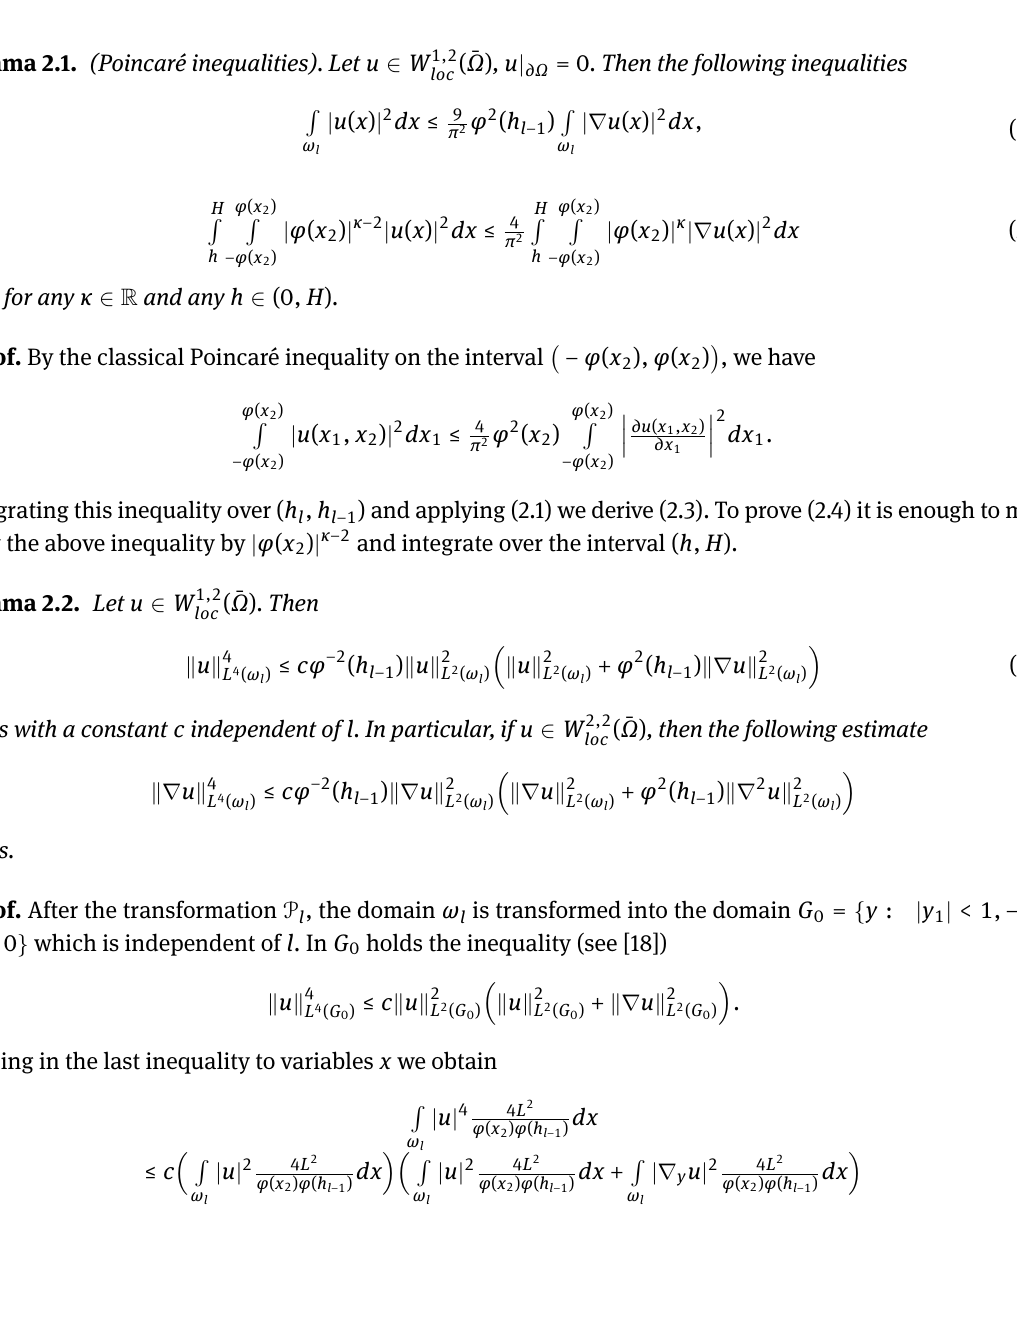
Fig. 3: Domains Ω K .